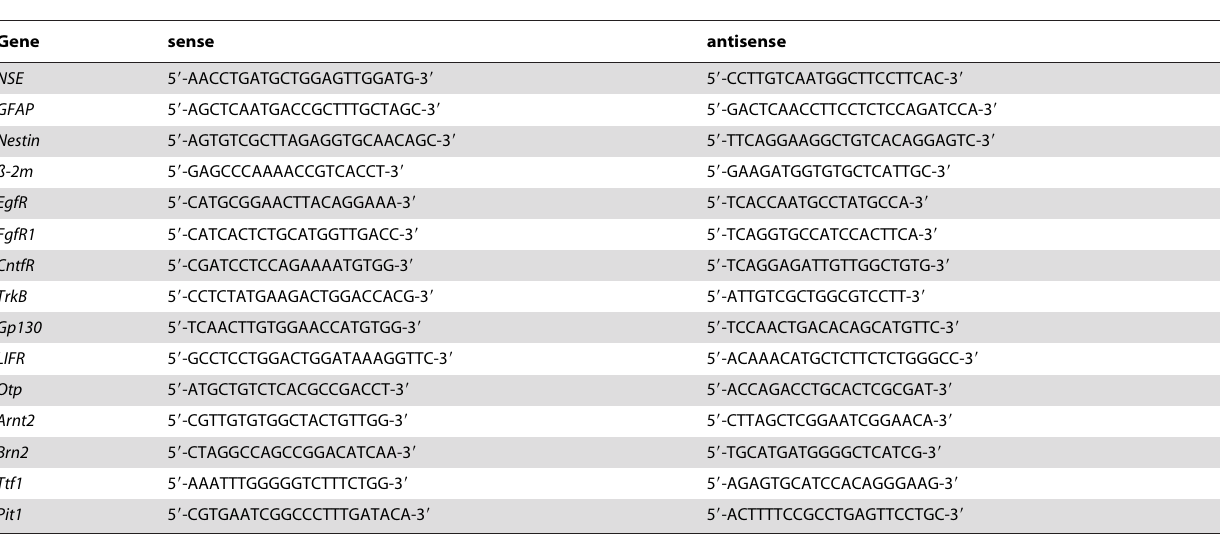
Table 1. Primers used for the PCR